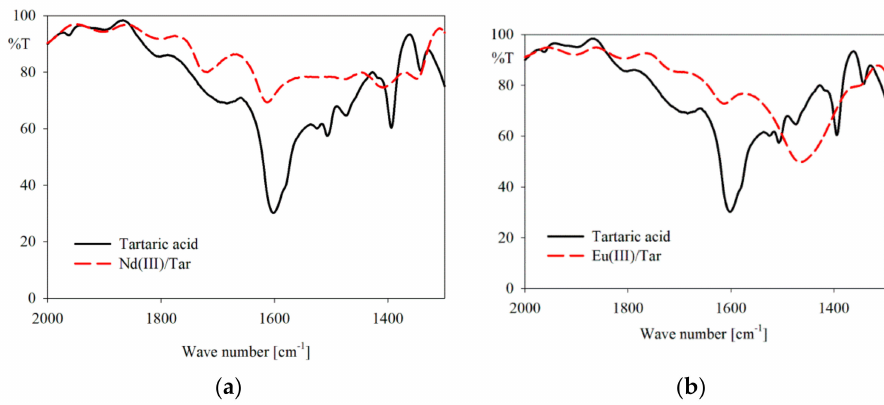
Figure 3. IR spectra of selected systems: ( a ) Nd(III) / Tar; ( b ) Eu(III) / Tar.